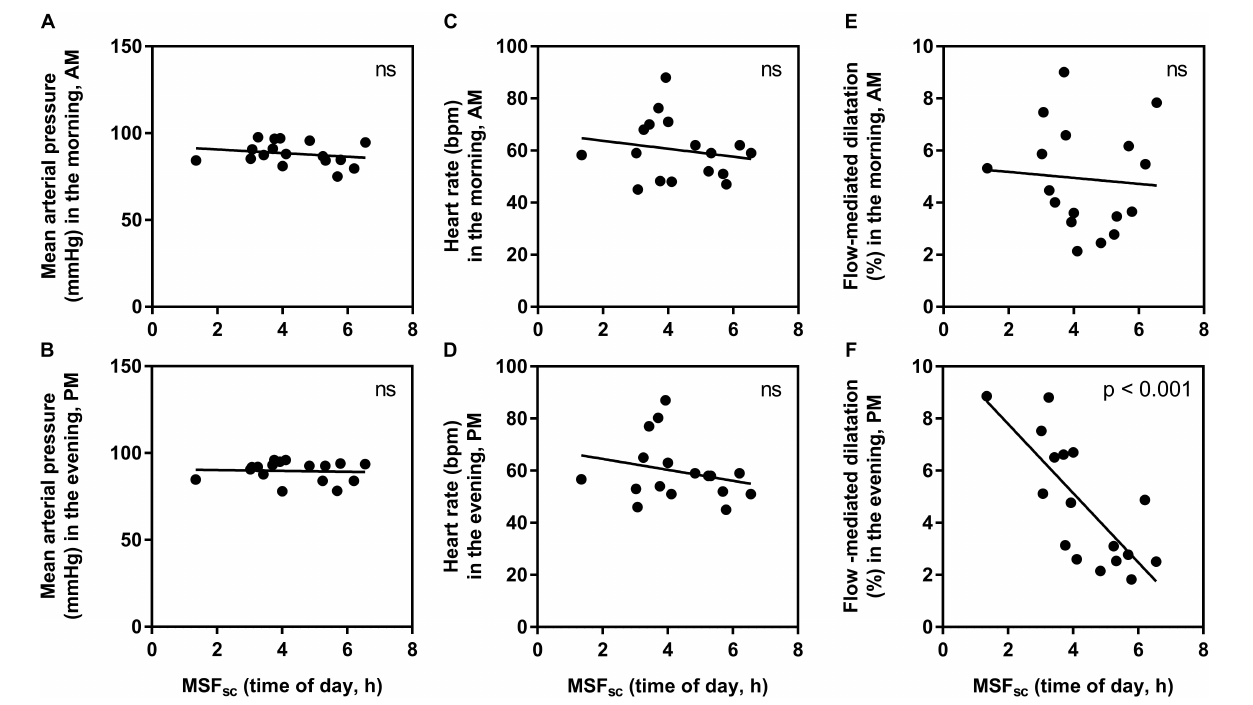
FIGURE 3 | The relationship between chronotype (corrected mid-sleep time on free days, MSF sc ) and absolute measurement values in the morning (AM) and evening (PM). (A) mean arterial pressure in the morning, (B) mean arterial pressure in the evening, (C) heart rate in the morning, (D) heart rate in the evening, (E) flow-mediated dilatation in the morning, (F) flow-mediated dilatation in the evening. Significance is shown in the top right corner (ns, not